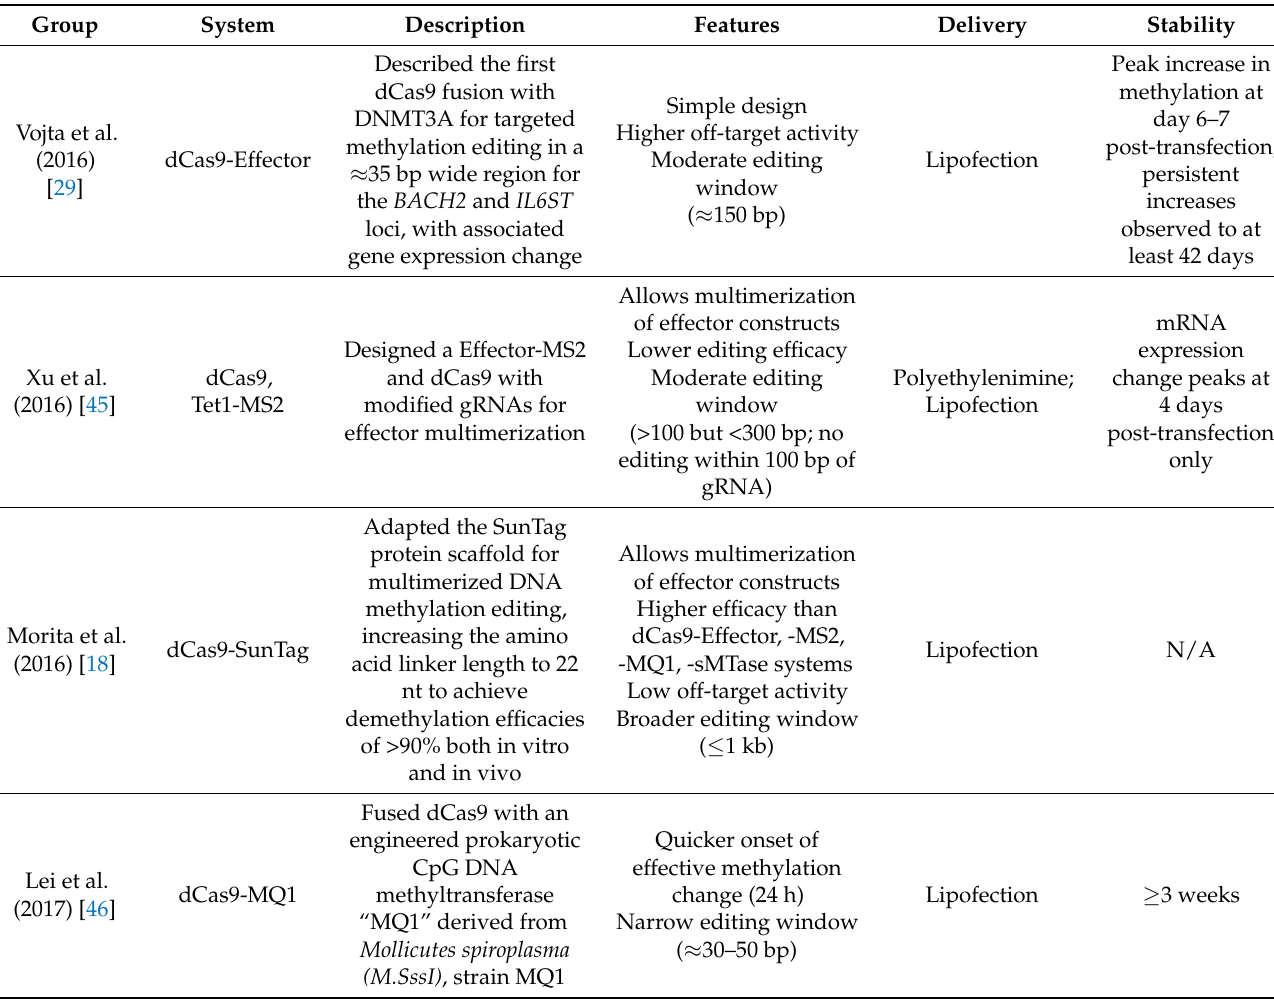
Table 1. Pioneering studies in the development of CRISPR-based DNA methylation editing systems for mammalian cells. Group System Description Features Delivery